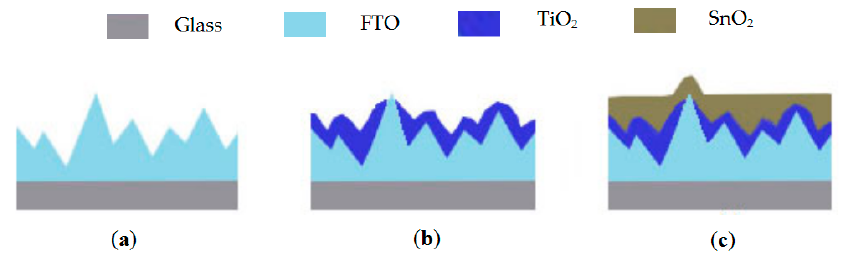
Figure 5. Schematic illustration for the solution spin ‐ coating process of TiO 2 /SnO 2 complementary